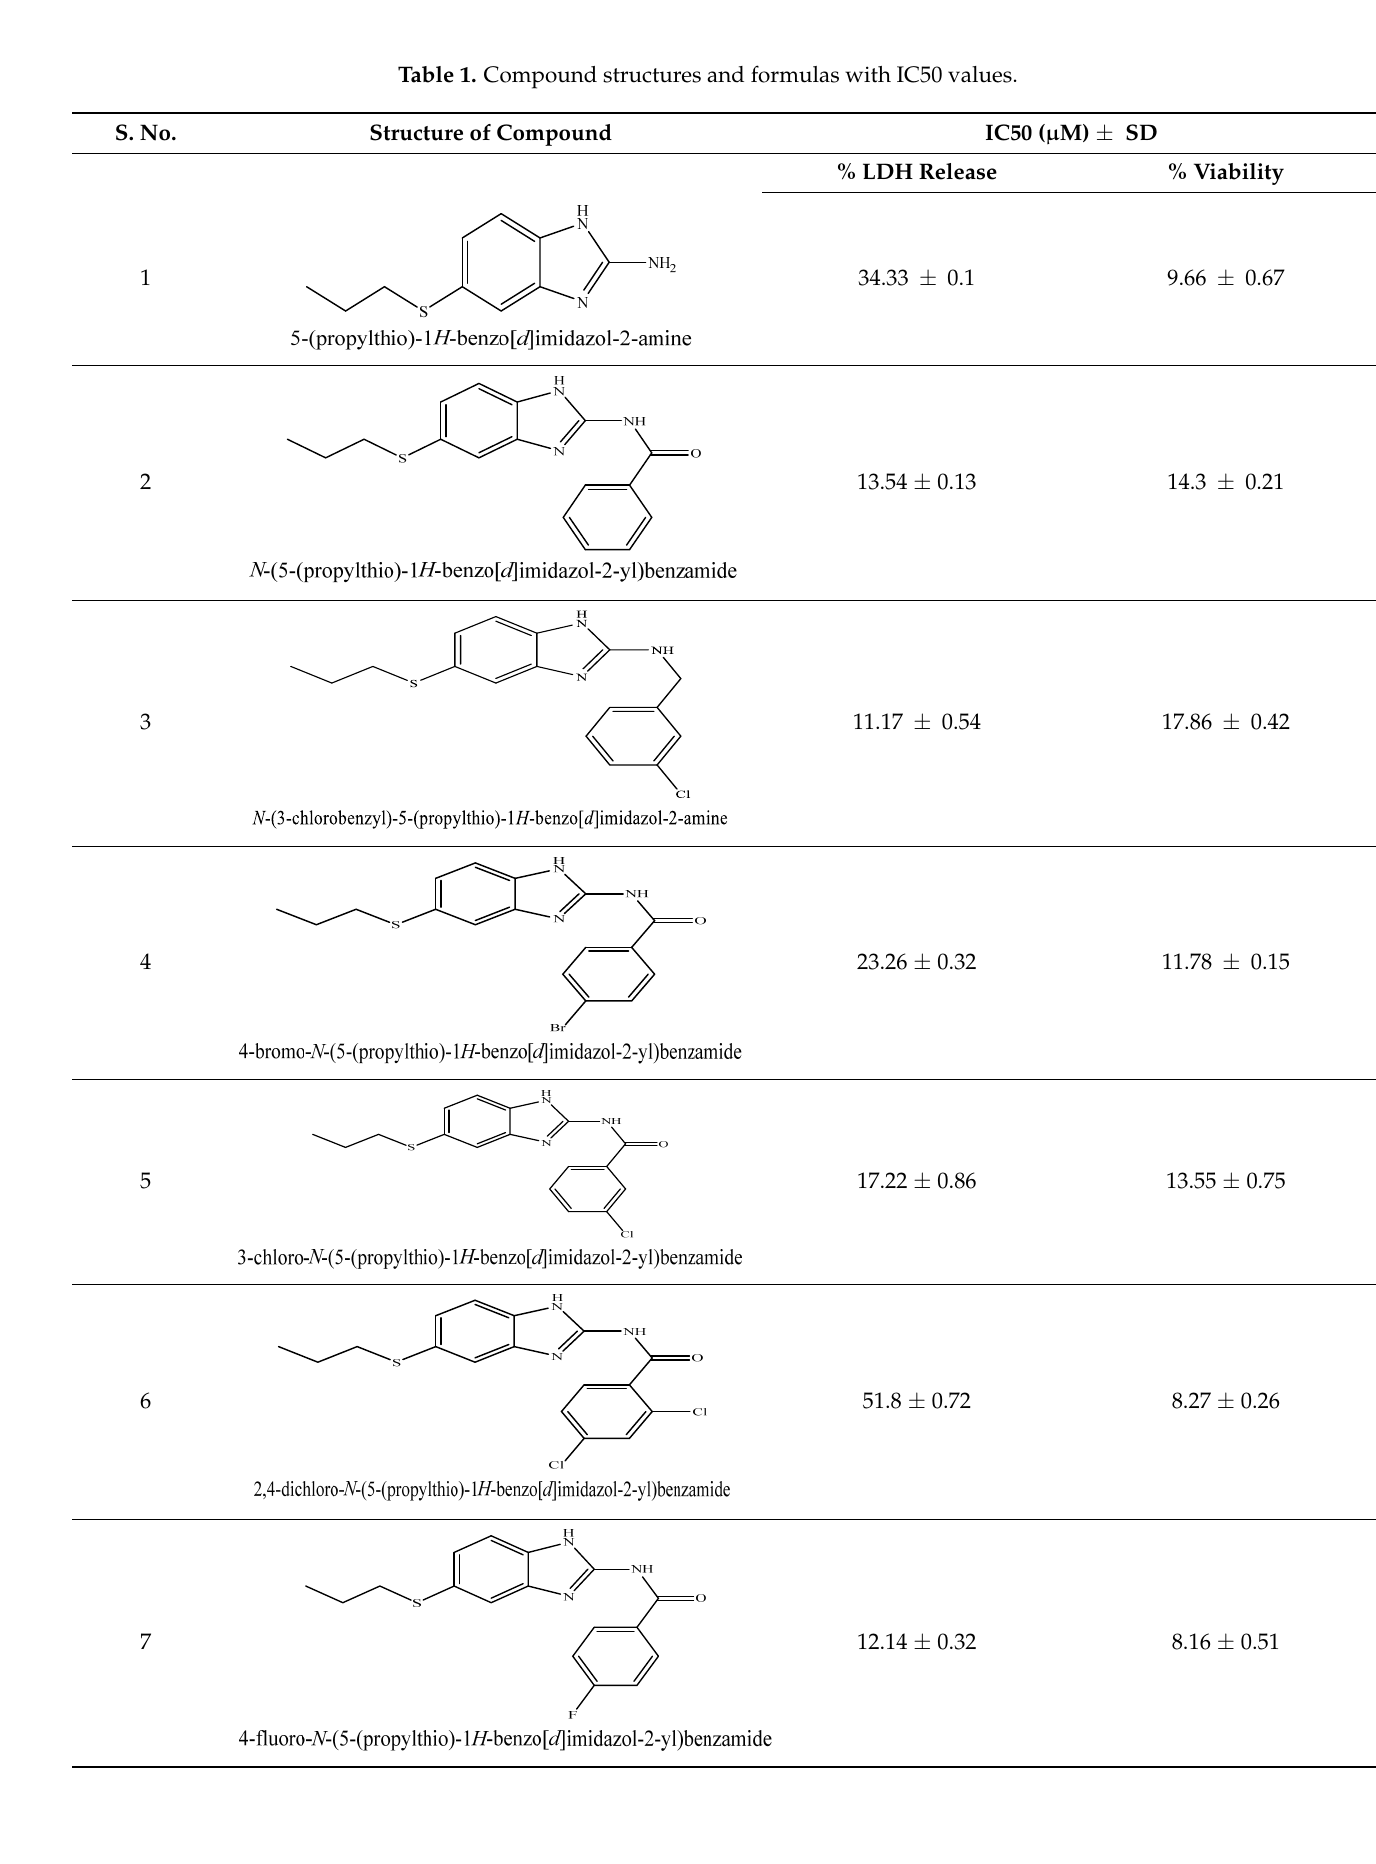
Table 1. Compound structures and formulas with IC50 values.